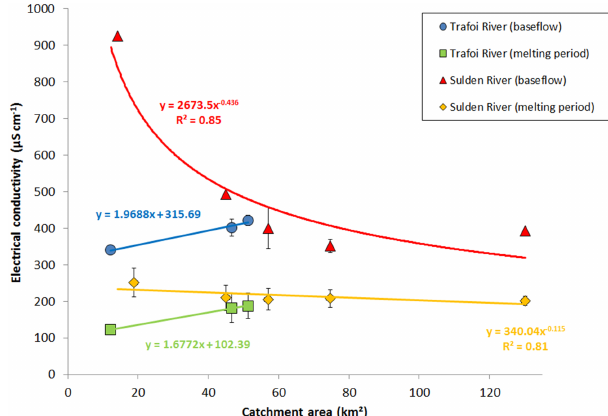
Figure 5. Spatial variability in electrical conductivity along the Trafoi and Sulden River against catchment area. Electrical con- ductivity is averaged for sampling days during baseflow conditions (21 January, 26 February and 18 March 2015) and melting period (12 June, 18 July, 11 August and 9 September